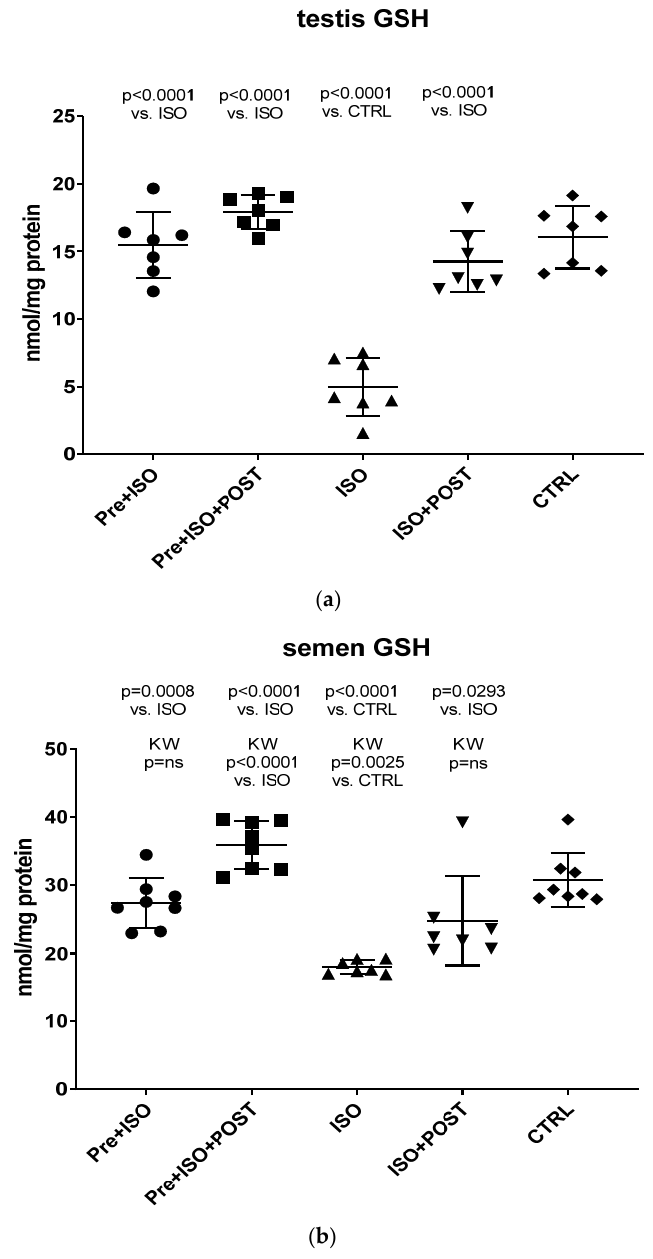
Figure 6. ( a ) The effects of isoproterenol treatment and exercise training on the testicular ratio of reduced/oxidized glutathione (GSH) content, expressed as nmol/mg protein. ( b ) The effects of isoproterenol treatment and exercise training on the ratio of reduced/oxidized glutathione (GSH) content of the semen, expressed as nmol/mg protein. The results are shown as mean ± S.D., n = 7–8/group, one-way ANOVA, Tukey’s post-test. Significant differences between treatment groups are shown with exact p values. PRE = Pre-swimming, ISO = Isoproterenol injection, POST = Post-swimming, CTRL = Control group, GSH = total glutathione.